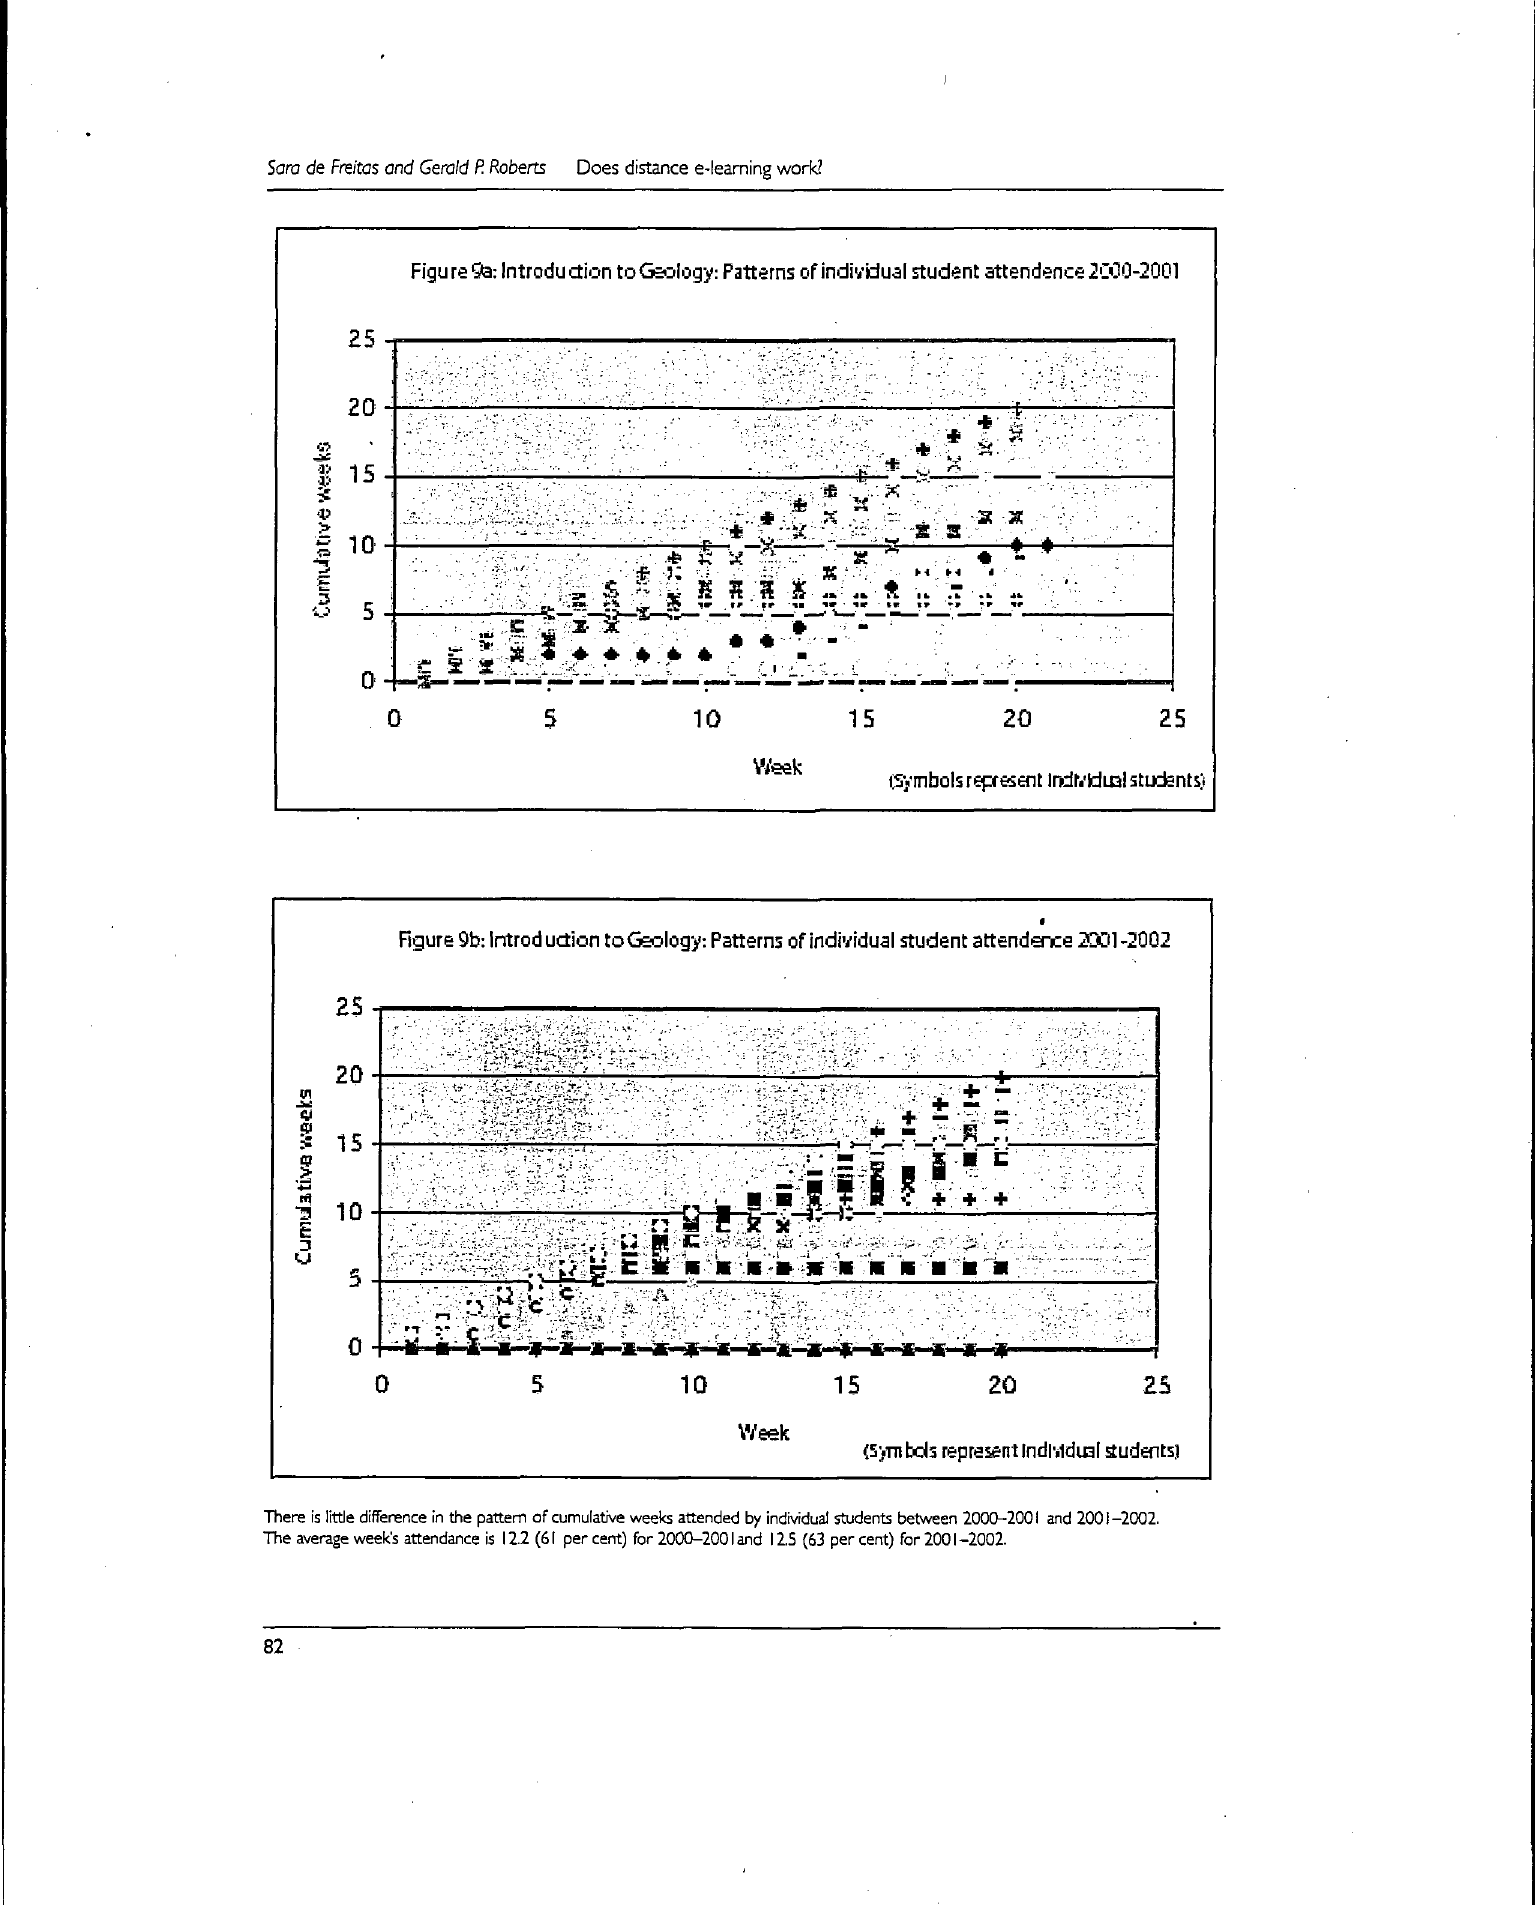
Figure 9a: Introduction to Geology: Patterns of individual student attendence2CO0-2001